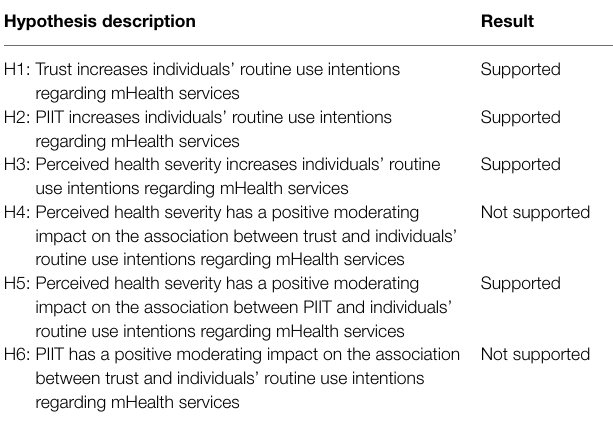
TABLE 6 | Summary of